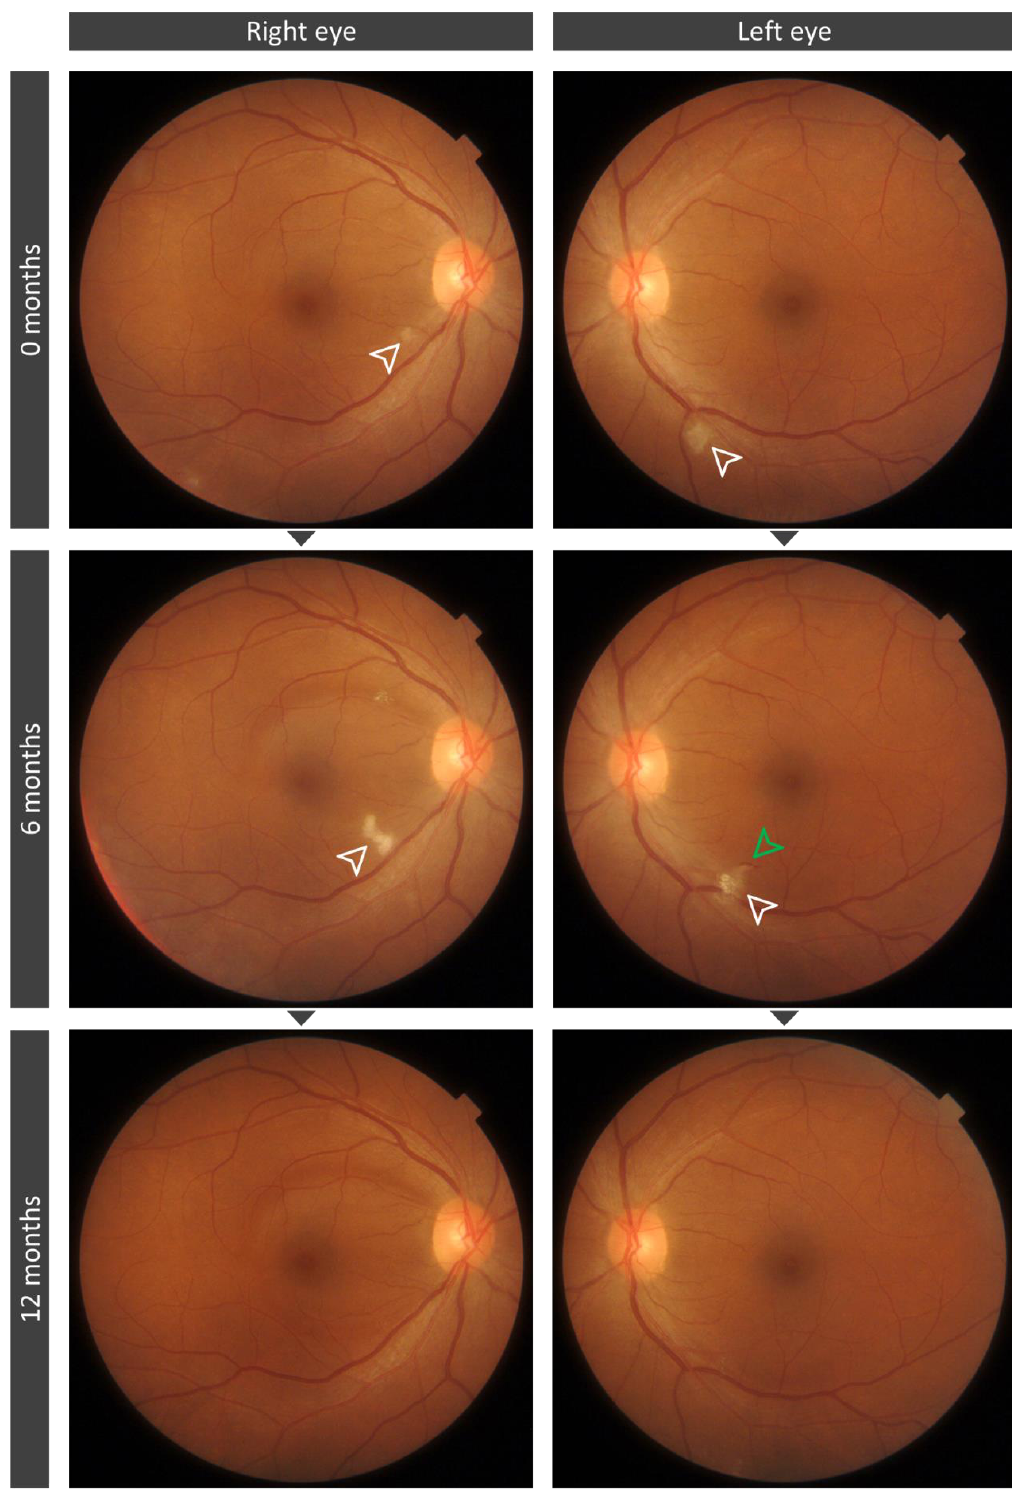
Figure 3. Composite fundus retinographies from both eyes of a 45-year-old woman with COVID-19 at 0 months after COVID-19 hospital discharge, 6 months later, and 12 months later. In this case, the patient presented cotton wool spots (CWSs) in both eyes in the first evaluation that were not present 6 months later, but new CWSs and a microhemorrhage were visible. Top row: Fundus retinography of the right and left eye at first evaluation. Middle row: Fundus retinography of the right and left eye at 6 months evaluation. Bottom row: Fundus retinography of the right and left eye at 9 months evaluation. White arrowheads indicate the CWSs. Green arrowhead indicates the microhemorrhage.